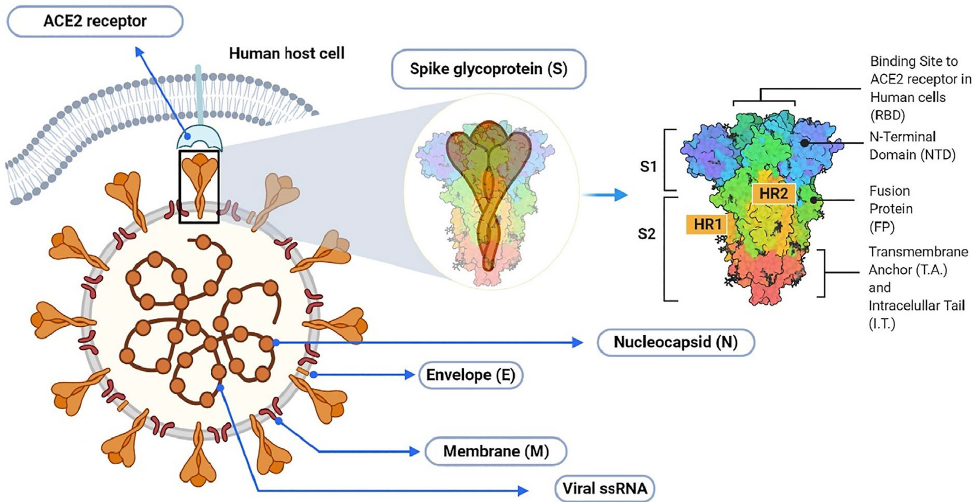
Figure 1. Schematic illustration of SARS-CoV-2 virion with detailed arrangement of spike receptor binding domain. Reproduced with minor editing privilege from Abubakar [9] under the Creative Commons Attribution License (CC BY).